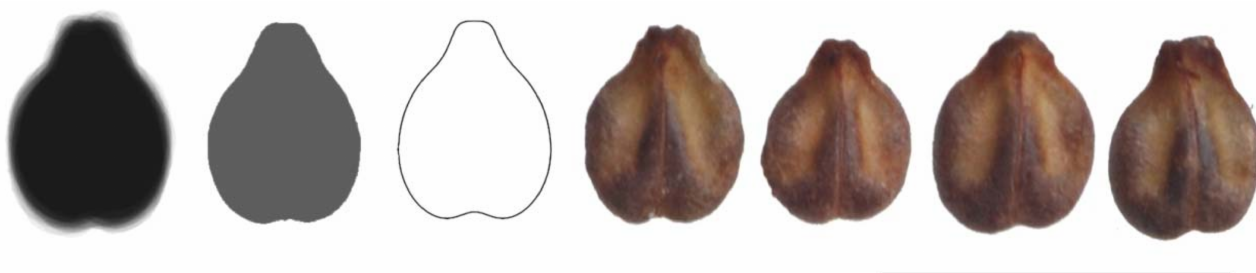
Figure 4. List á n Prieto Model. From left to right: An image with the sum of the silhouettes of 30 seeds, average silhouette obtained from the first image, the List á n Prieto model, and four representative seeds of this cultivar. Bar represents 1